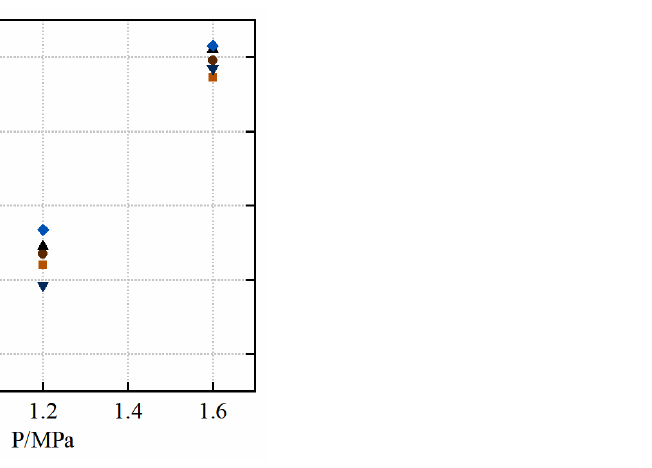
Figure 5. Correlation between strain rate and impact pressure of the samples under different loading conditions.